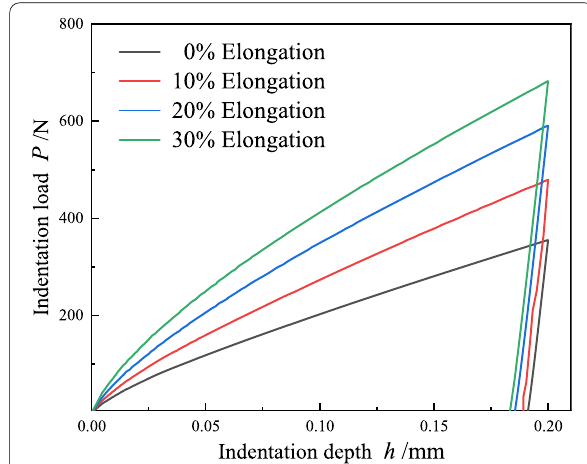
Figure 15 The load-depth curves obtained by finite element reversion under different elongations